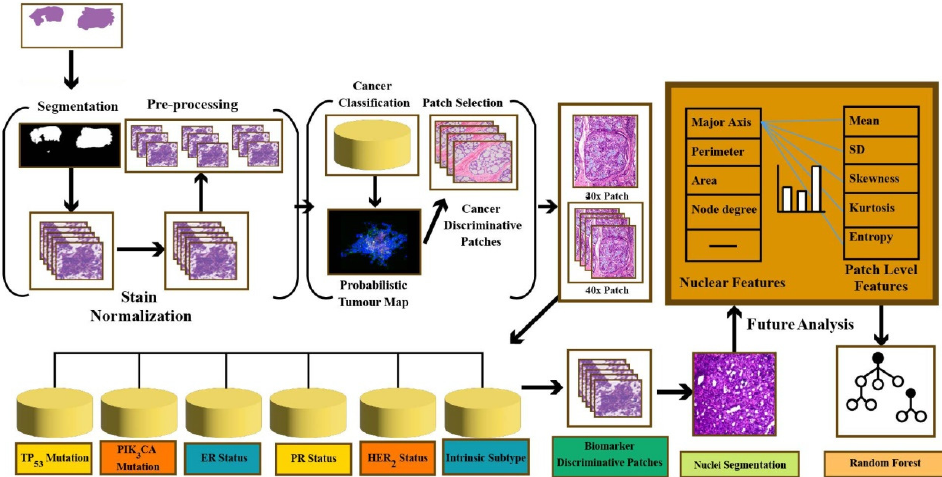
Figure 9. Predict genomic biomarkers—TP53 mutation model.